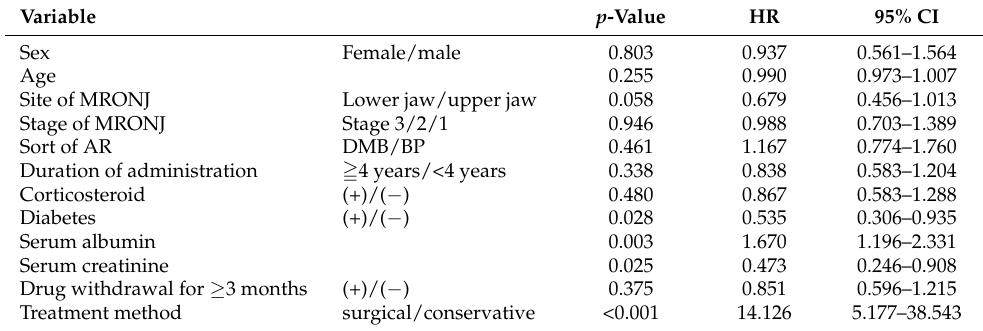
Table 2. Factors related to healing rate of MRONJ by univariate analysis (Total: 166 patients).